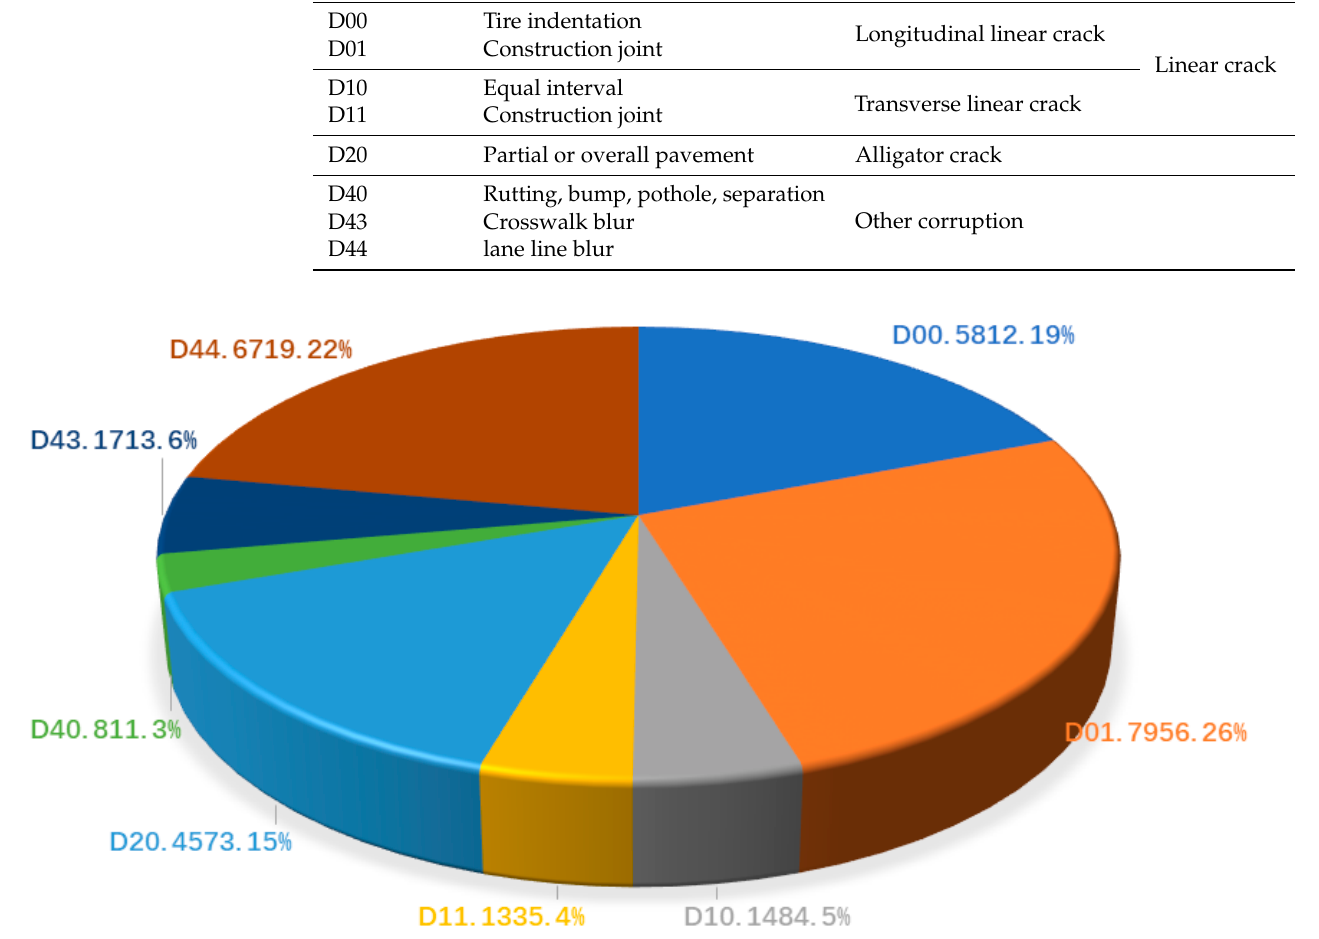
Figure 6. The number of each road damage categories in the GRDDC’2020 dataset as a percentage of the ground truth.